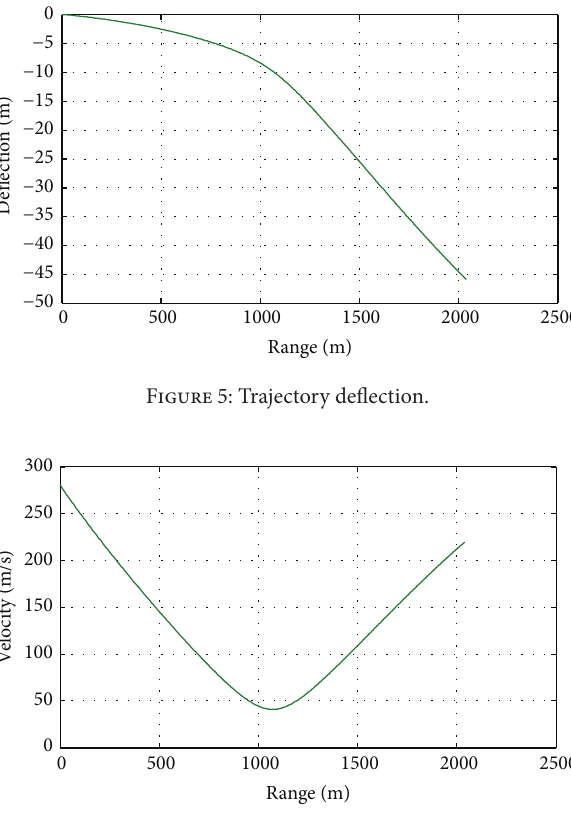
Figure 6: Total velocity.